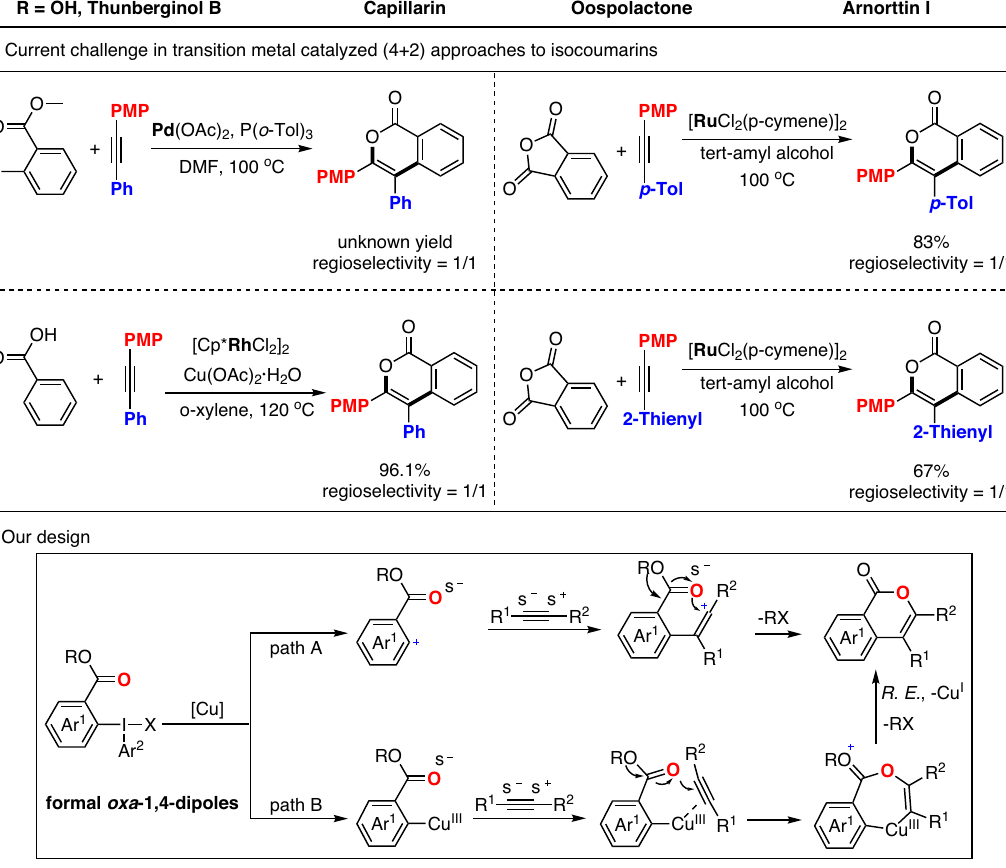
Fig. 1 Formal oxa-1,4-dipoles based on diaryliodonium salts and the challenge in the synthesis of isocoumarins. a Selected examples of natural products and drugs containing the isocoumarin core structure. b Current challenge in transition metal catalyzed (4 + 2) approaches to isocoumarins. c Our